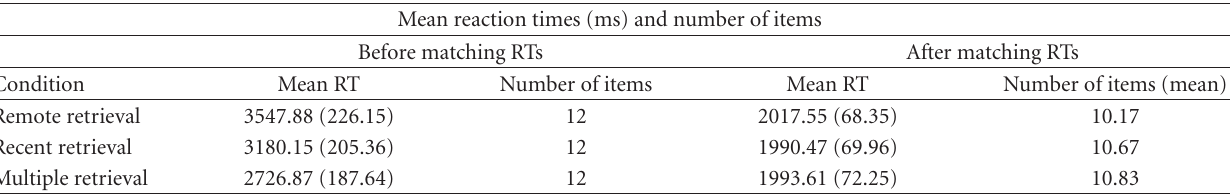
Table 5: Mean reaction times and number of items before and after matching RTs. A secondary analysis was conducted in which the mean RTs were equated across all three retrieval conditions by removing 0–3 items from the analysis. This analysis was conducted on six out of the twelve participants. Standard errors are noted in parentheses (reaction time (RT), millisecond